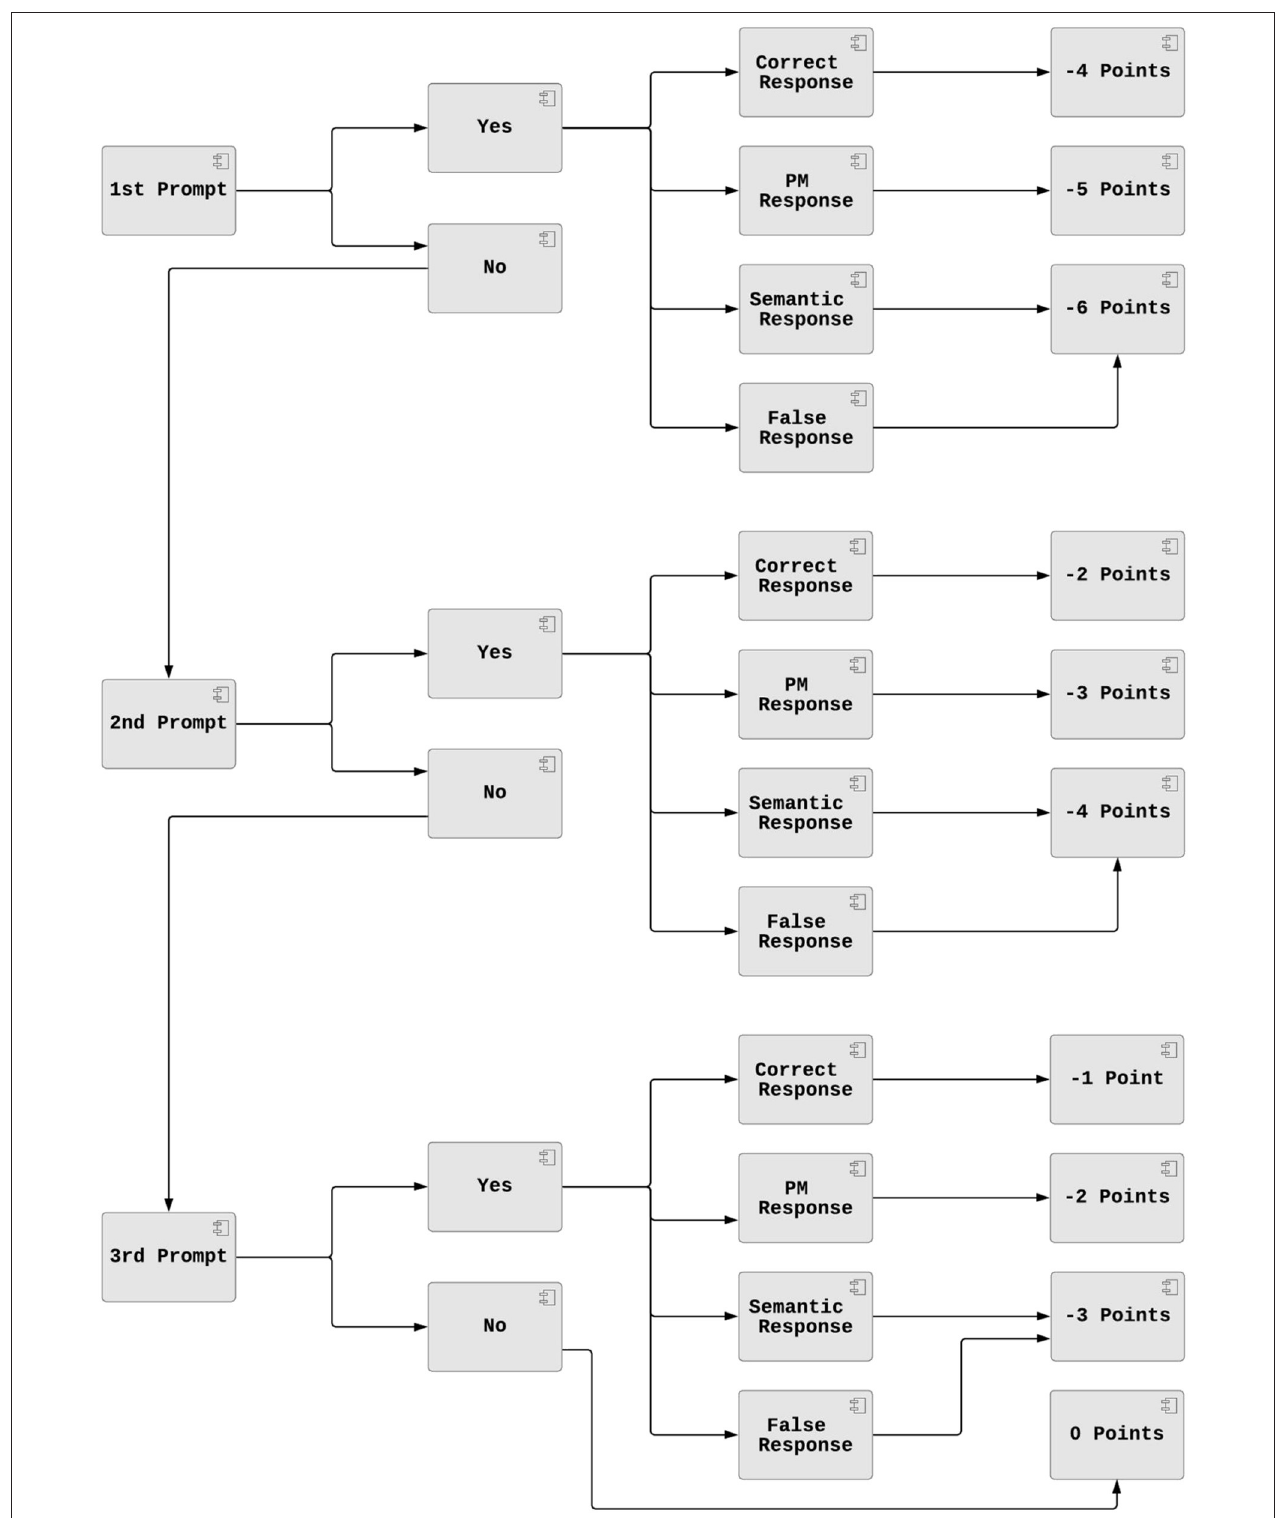
FIGURE 7 | Prospective memory: negative scoring